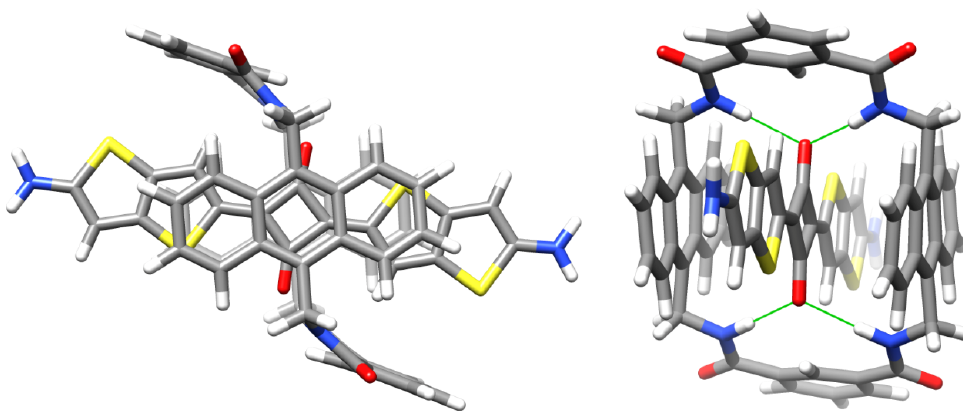
Figure 3. Molecular model of M1 ⊃ S3 (squaraine and macrocycle alkyl groups removed for clarity), calculated by the semiempirical method at PM7 level, showing the encapsulated squaraine in a trans conformation and ends of the squaraine’s thienothiophene units outside the shielding zone of M1 . ( left ) front view, ( right ) side view. Hydrogen bonds between macrocycle NH residues and squaraine oxygen atoms are indicated by green lines. Color code for atoms: grey = carbon, blue = hydrogen, blue = nitrogen, red = oxygen, yellow = sulfur.